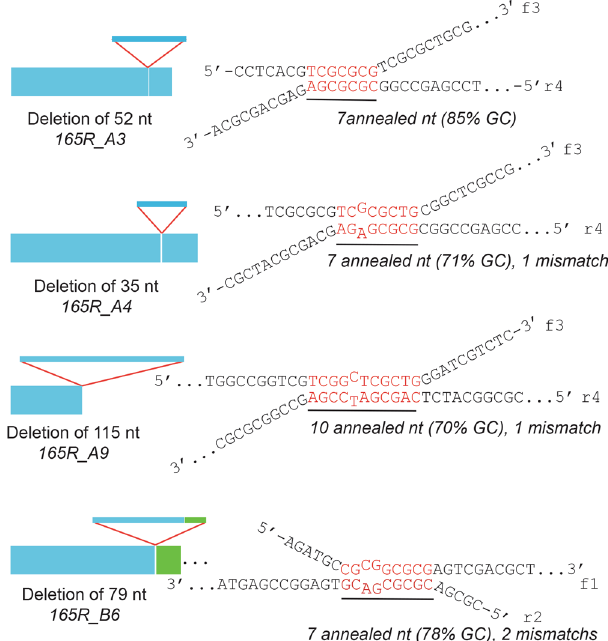
Figure 3. Origin of large deletions in G/C rich 165 bp DNA arrays. Left panel. Exemple analysis of 4 edited clones showing large deletions in the intended monomer sequence. A monomer is depicted by a blue rectangle, indicating the position and relative size of each deletion observed. Edited clone number is indicated and the sequence can be found in Supplementary Fig. s9. (Right panel). Proposed oligonucleotide annealing explaining observed monomer sequence variability in G/C rich 165 bp tandem DNA arrays.